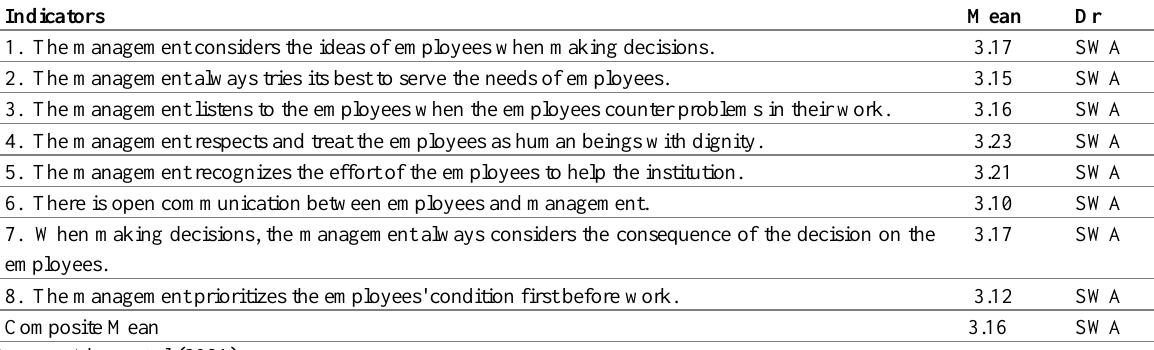
Table 4: The Work Environment of the Divine Word Colleges in the Ilocos Region in terms of Humanistic Environment